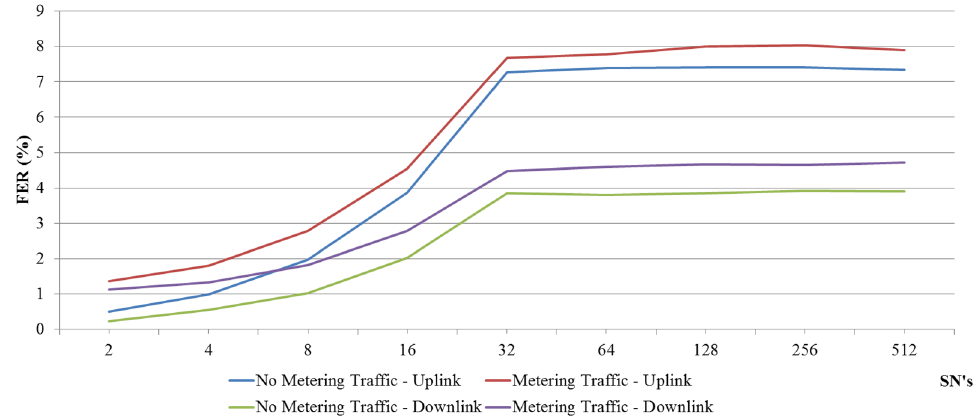
Figure 1. Frame error rate (FER) simulation based on ITU-T G.9904. International telecommunication union: ITU.